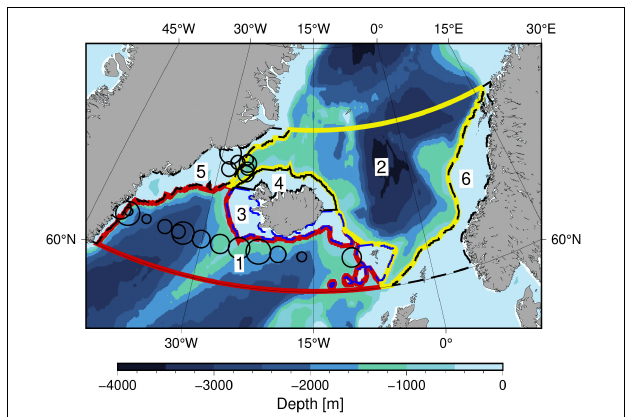
FIGURE 1 | Lambert azimuthal equal-area map of the sub-polar north-eastern North Atlantic with six subdomains between 60–70 ◦ N and divided between shelf-areas (depths less than 500 m) and open ocean areas: (1) Sub-polar gyre south of GSR (red), (2) Nordic Seas north of GSR (yellow), (3) Southern open shelf south of Iceland and including shelf and shallow areas around the Faroes (blue dashed), (4) Northern open shelf area north of Iceland (black), (5) Eastern shelf along Greenland (dashed), and (6) Western shelf along Norway (dashed). Circles show location and the relative size of P B max -values shown in Figure 7